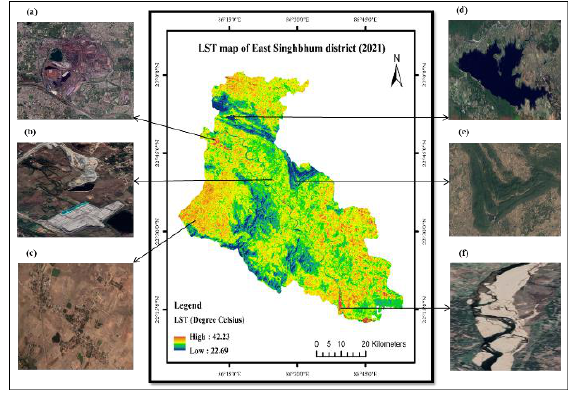
Figure 3 . LST variation in response to LULC; (a) Industrial and settlement area (b), quarrying/mining area (c) agricultural and settlement (d), waterbody (e) Vegetation, (f) Bare ground The mean of the LST for the year 2021 retrieved by the SMW algorithm ranged between 22.69 to 42.23 degree Celsius. The distinct thermal signatures exhibited in the LST maps are due to the different attributes of the various land use/cover type. Throughout the period, temperatures were high in places with various factories and industries, mining and quarrying locations, urban settlements, and agricultural lands. On the other hand, waterbody and vegetation have the lowest temperature throughout the area. The graph shown in Figure 4 depicts a positive correlation between urban spectral indices’ (BSI, EBBI, MNDWI, NBAI, NBI, NDBaI, NDBI, NDBSI, NMDI, and UI) and the LST. In the case of vegetation and waterbody, the opposite is supposed to be true. Here the vegetation indices are negatively correlate with LST because wherever there is vegetation cover, the surface temperature is low (Mishra et al., 2021). Similarly, the NDWI-LST relation is low as water temperature varies with its surroundings, implying a negative correlation between them.